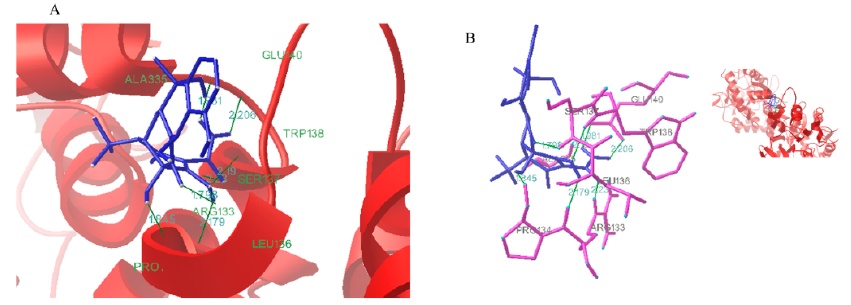
Figure 6. Molecular modeling study predicted orientation of the binding conformation of TCH with bLf. ( A ) Secondary structure of bLf around TCH. ( B ) Hydrogen bond between bLf with TCH.